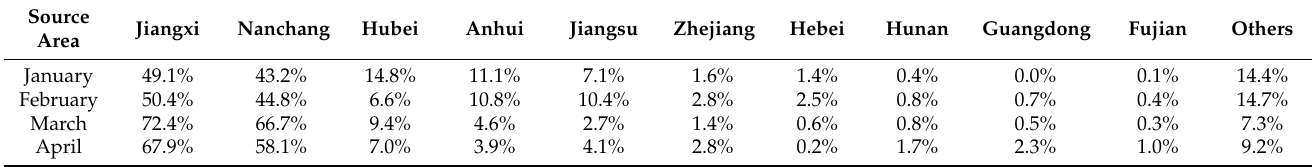
Table 1. Proportions of enhancement contribution from different provinces and Nanchang city, note Jiangxi province contains Nanchang